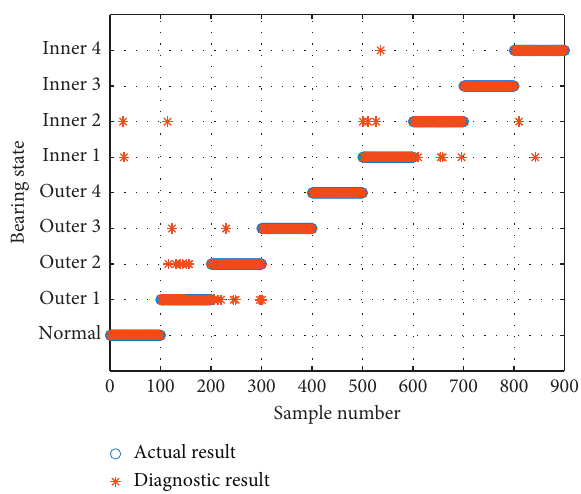
Figure 19: Degradation identification results of constant speed